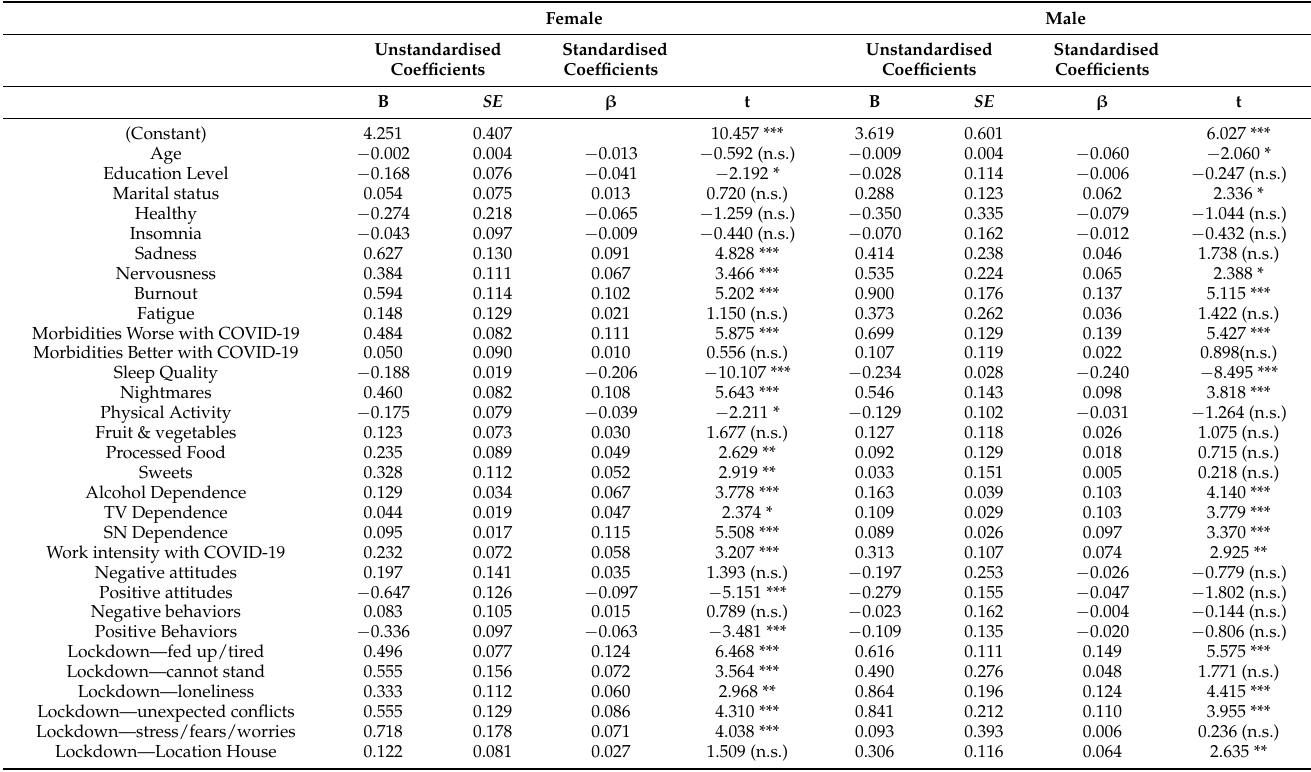
Table 3. Linear regression—variable dependent Calamity Experience Checklist—gender